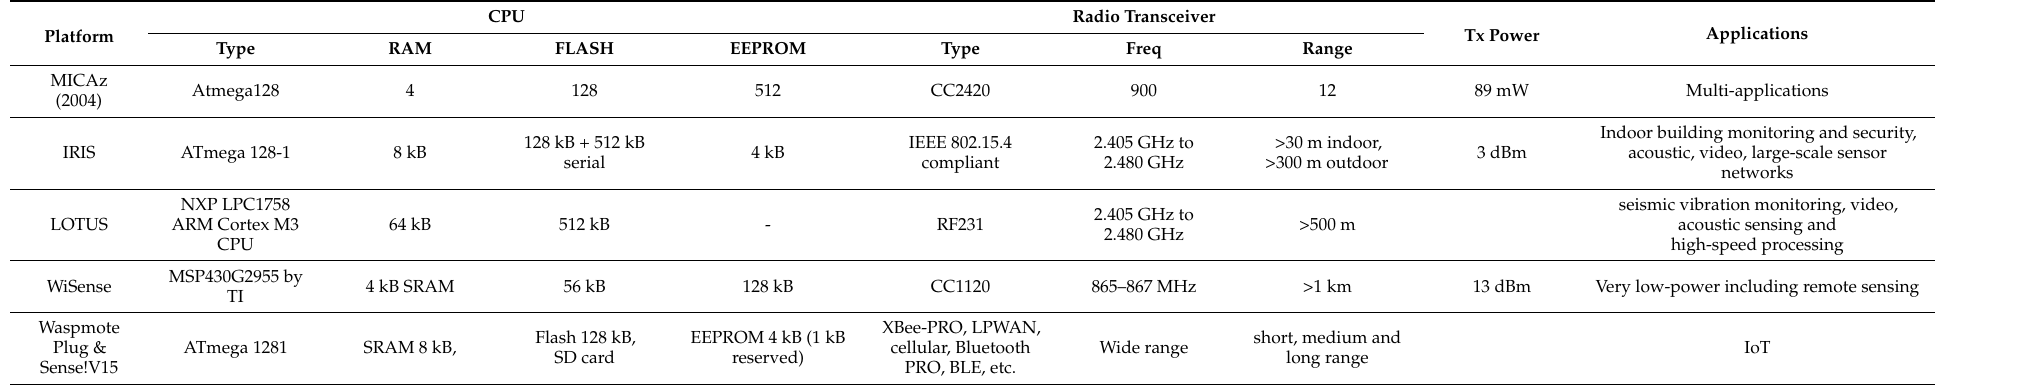
Table 2. A Summary of features and applications of widely used selected commercial